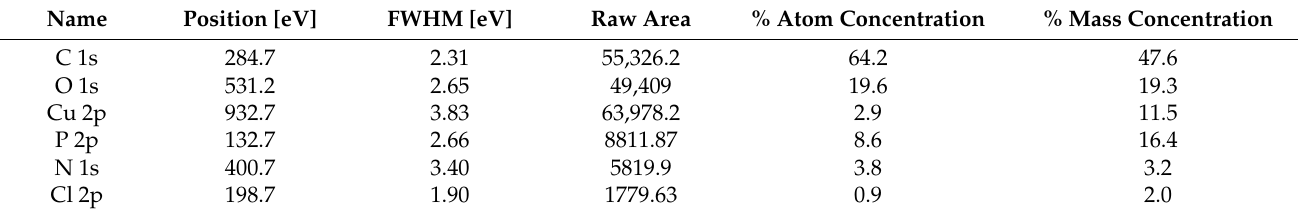
Table 6. The elemental composition determined for Purolite S 940 after the Cu(II) ion sorption